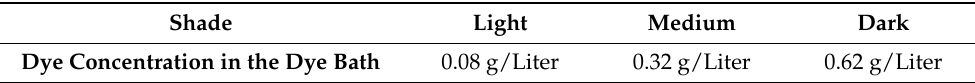
Table 5. Dye concentration in the dye